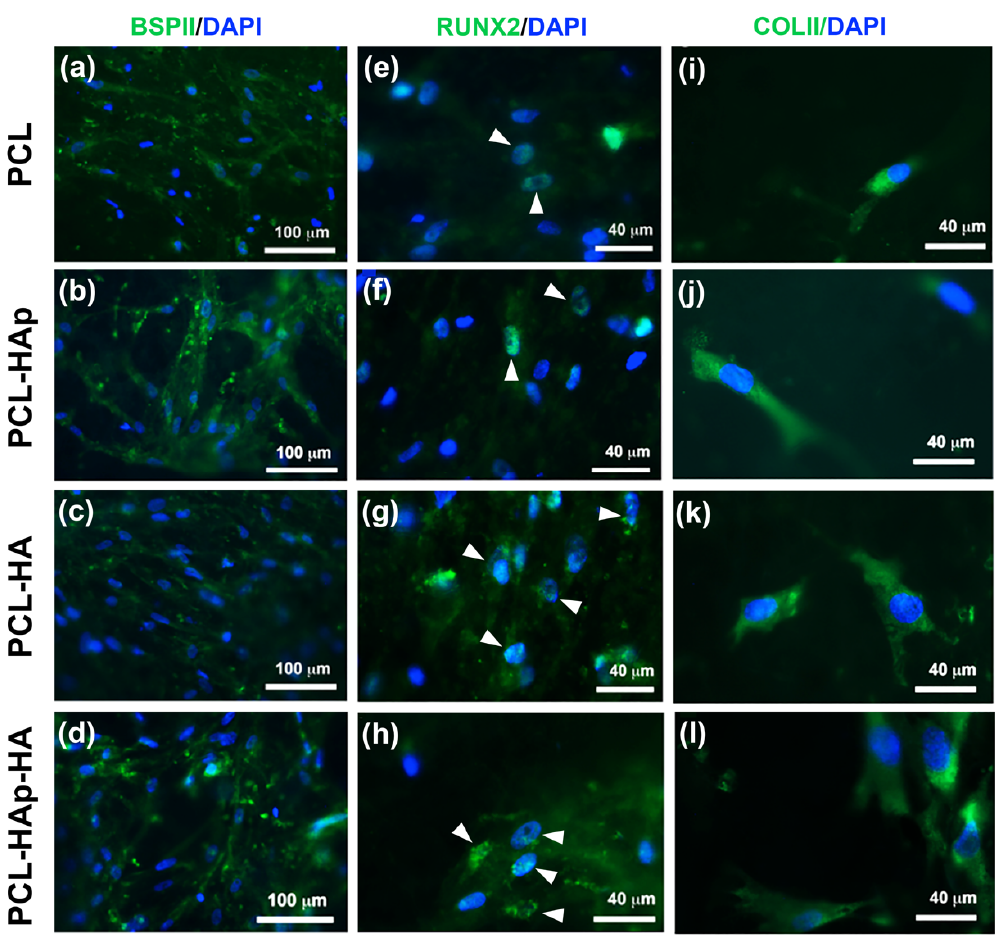
Figure 3. Indirect immunofluorescence of bone specific proteins BSPII ( a – d ) and RUNX2 ( e – h ) and chondrogenic protein Collagen type II (COLII) ( i)–(l ) on the hBM-MSCs seeded scaffolds: PCL, PCL-HAp, PCL-HA, and PCL-HAp-HA in an osteogenic medium ( a – h ) or chondrogenic medium ( i – l ) for 21 days. The white arrowheads indicate the nuclear staining ( e – h ). The nuclei are stained in blue (DAPI).